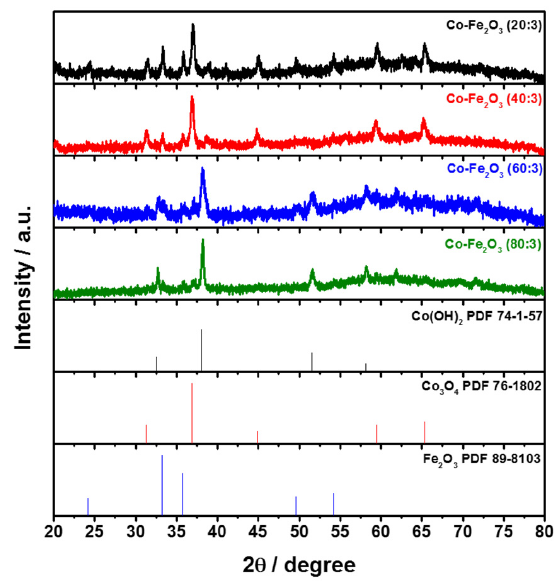
Figure 3. XRD patterns for different ratios between iron and cobalt precursors.